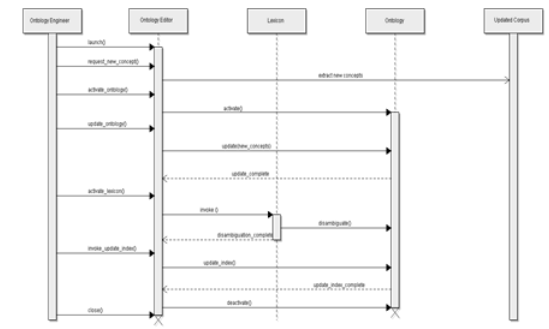
Fig. 5. Sequence diagram for the Law-Torch system’s ontology update use.